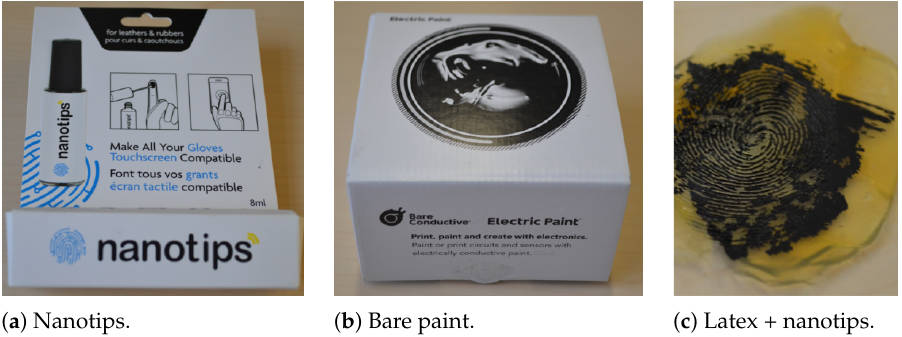
Figure 5. Conductive augmentations can be created by applying, e.g., nanotips ( a ) or electric bare paint ( b ) to the fingerprint PAI ( c